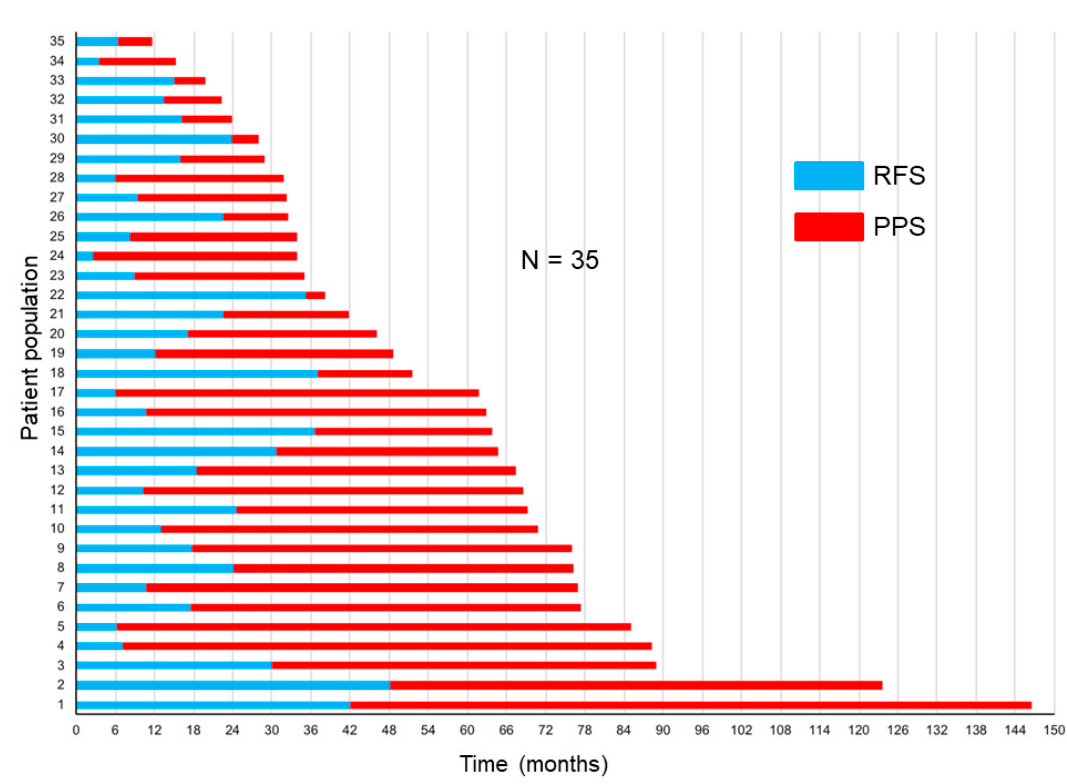
Figure 4. Relapse-free survival (RFS) and post-progression survival (PPS) in the entire study population. Table 3. Univariate and multivariate analyses of patient backgrounds for post-progression